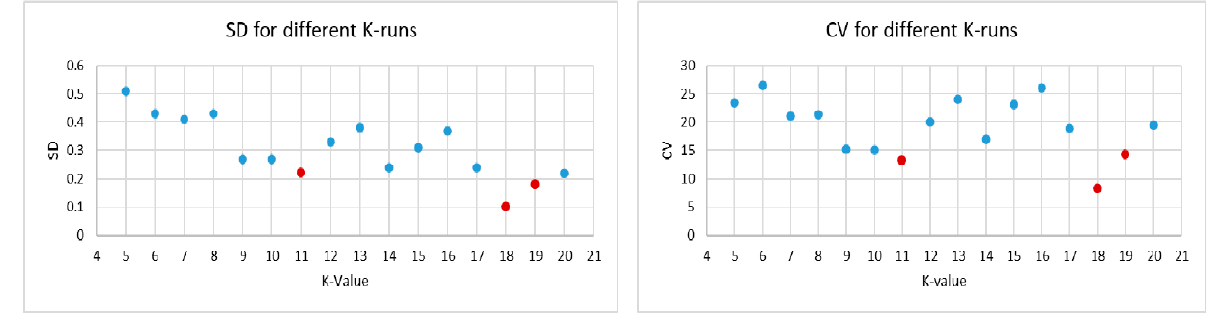
Figure 4. The SD and CV values for difference K-runs the red dots indicate k-values that exhibit both low SD and CV values.